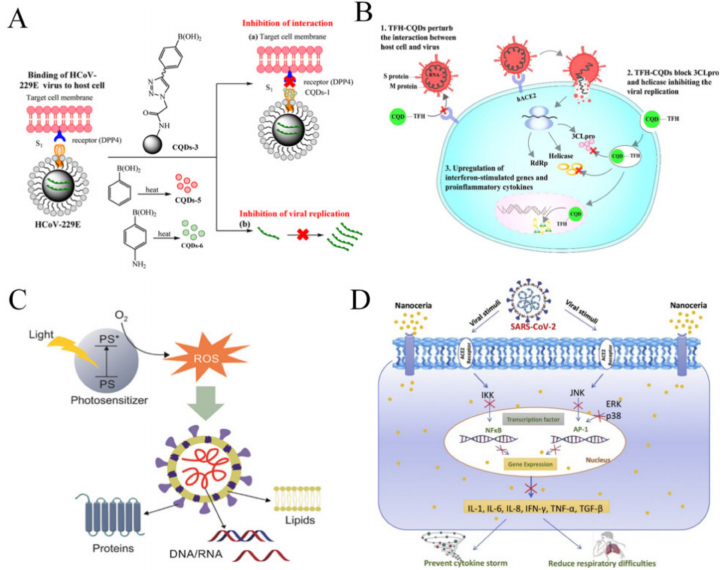
Figure 4. The application of nanoparticles for potential COVID-19 treatment. ( A ) Carbon quantum dots inhibit binding of S protein receptor of coronavirus to host cells and prevent viral RNA genome amplification. Adapted with permission from reference [106] © Creative Commons Attribution License (2020). ( B ) Triazole-based carbon quantum dots were suggested for use as an antiviral agent to treat COVID-19. Adapted with permission from reference [162] © Elsevier (2020). ( C ) Semicon- ductor nanoparticles, including quantum dots can generate antiviral radicals by interacting with light. Adapted with permission from reference [9] © Creative Commons Attribution License (2020). ( D ) Nanoceria inhibits cytokine storm due to its strong anti-inflammatory effects, serving as a thera- peutic agent for COVID-19. Adapted with permission from reference [163] © Creative Commons Attribution License